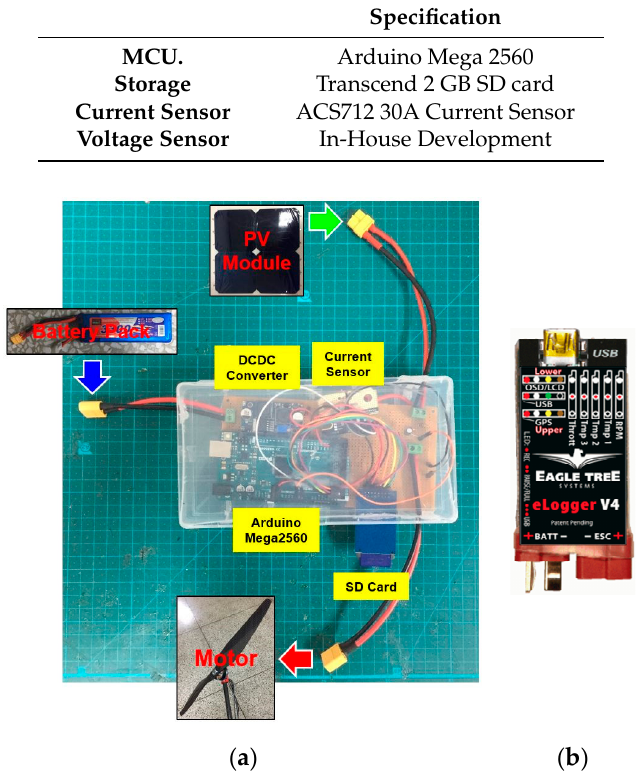
Figure 9. Hardware of the PPRS and eLogger V4: ( a ) PPRS and ( b ) eLogger V4.